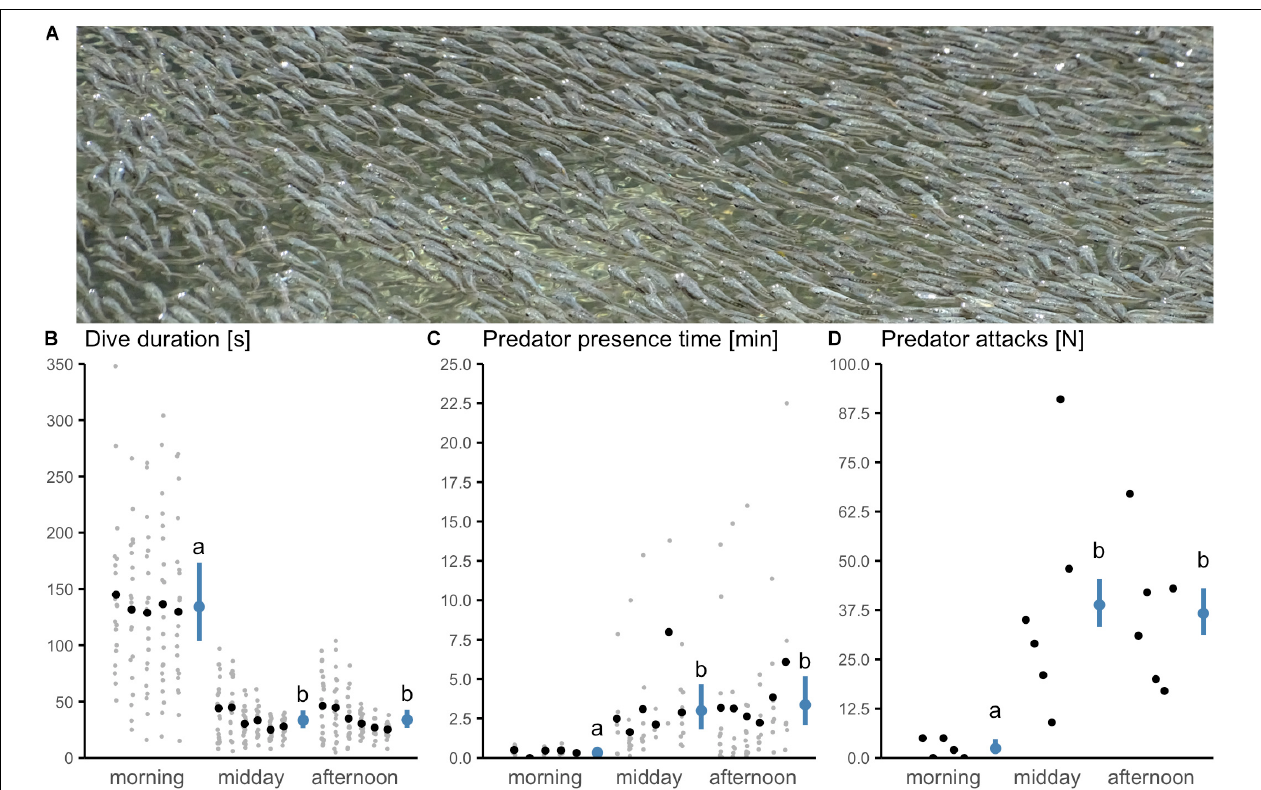
FIGURE 2 | Diurnal variation in sulphur mollies’ diving behavior and predatory birds’ activity. (A) During daytime hours, sulphur mollies spent large amounts of time at the surface performing aquatic surface respiration, often resulting in densely-packed shoals. A stream section was repeatedly sampled during three daytime periods on six consecutive days ( n = 17 sampling occasions; morning Day 1 excluded). Shown are measurements (gray), which were sample-pooled for analysis (black). Time of day affected (B) prey’s behavior (mean dive duration) as well as predator’s activity [ (C) : mean presence time and (D) : total sum of attack; see model-estimated marginal means with 95% CI in blue]. Letters indicate results from post hoc pairwise comparisons.